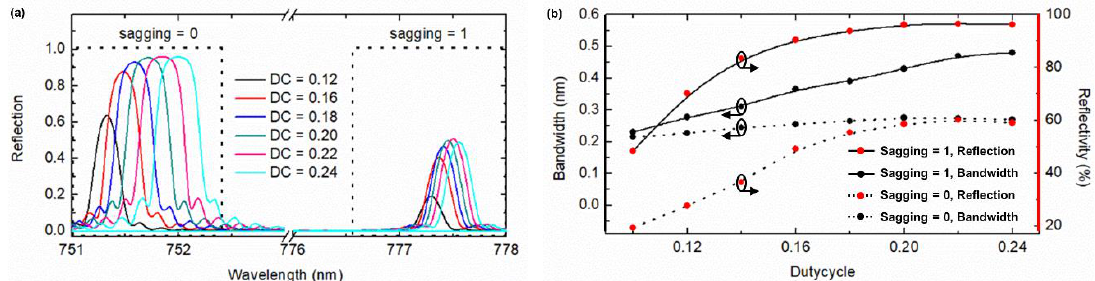
Figure 6. ( a ) Spectra and ( b ) bandwidth and reflectivity of the third order Bragg grating as a function of the duty cycle ( p = 756.5 nm and h = 200 nm).